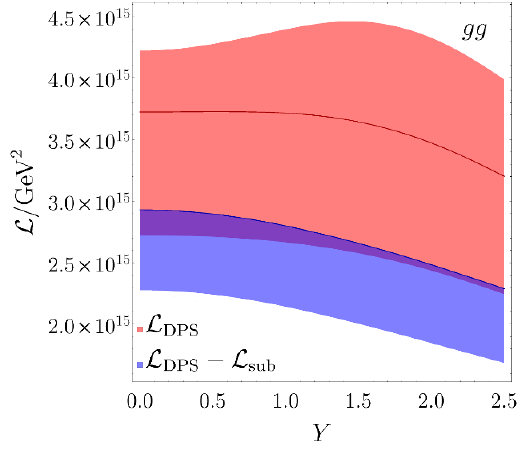
Figure 16 . As in figure 13b, but for different kinematics, with µ = 10 GeV and all x set equal to 7 . 1 10 − 4 , corresponding to Q 1 = Q 2 = 10 GeV at √ s = 14 TeV. Notice the suppressed zero on × the L